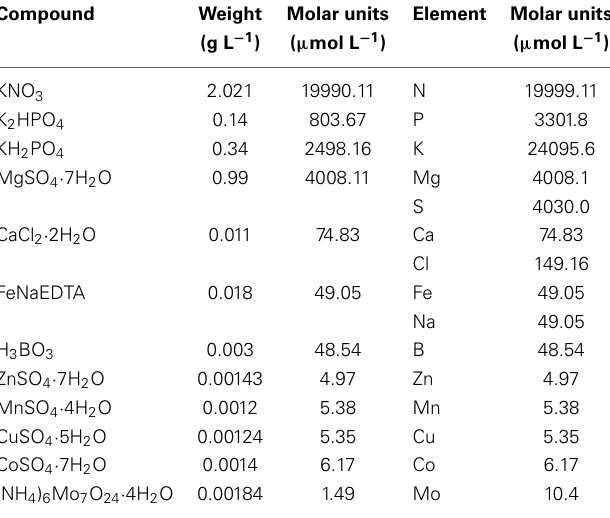
Table 2 | Composition of the ŠS-medium (Zachleder and Šetlik, 1982). Compound Weight Molar units Element Molar